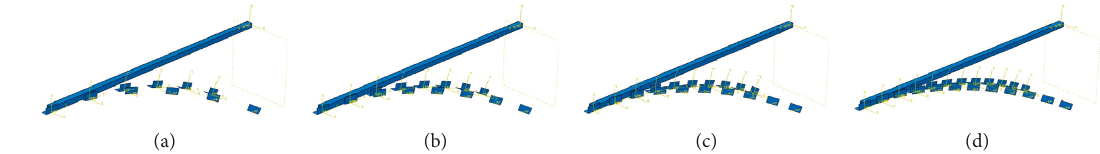
Figure 14: Assembly drawing with different number of die heads: (a) C � 6; (b) C � 8; (c) C � 10; (d) C �